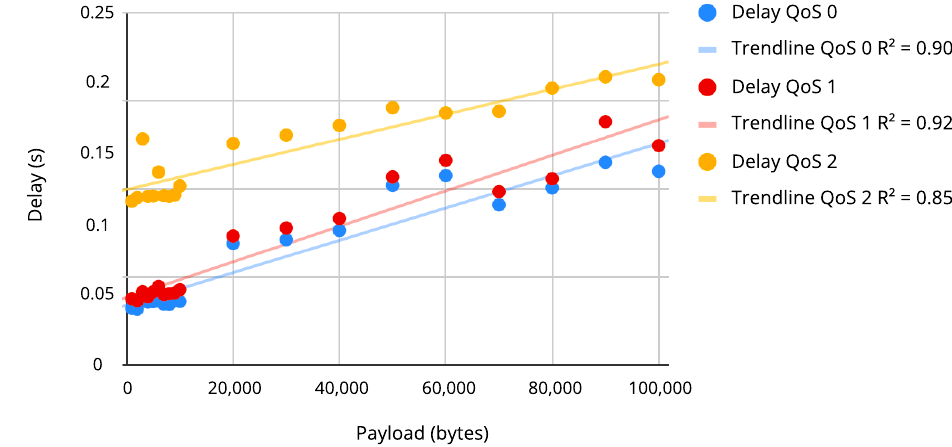
Figure 10. Payload × Delay on Ethernet